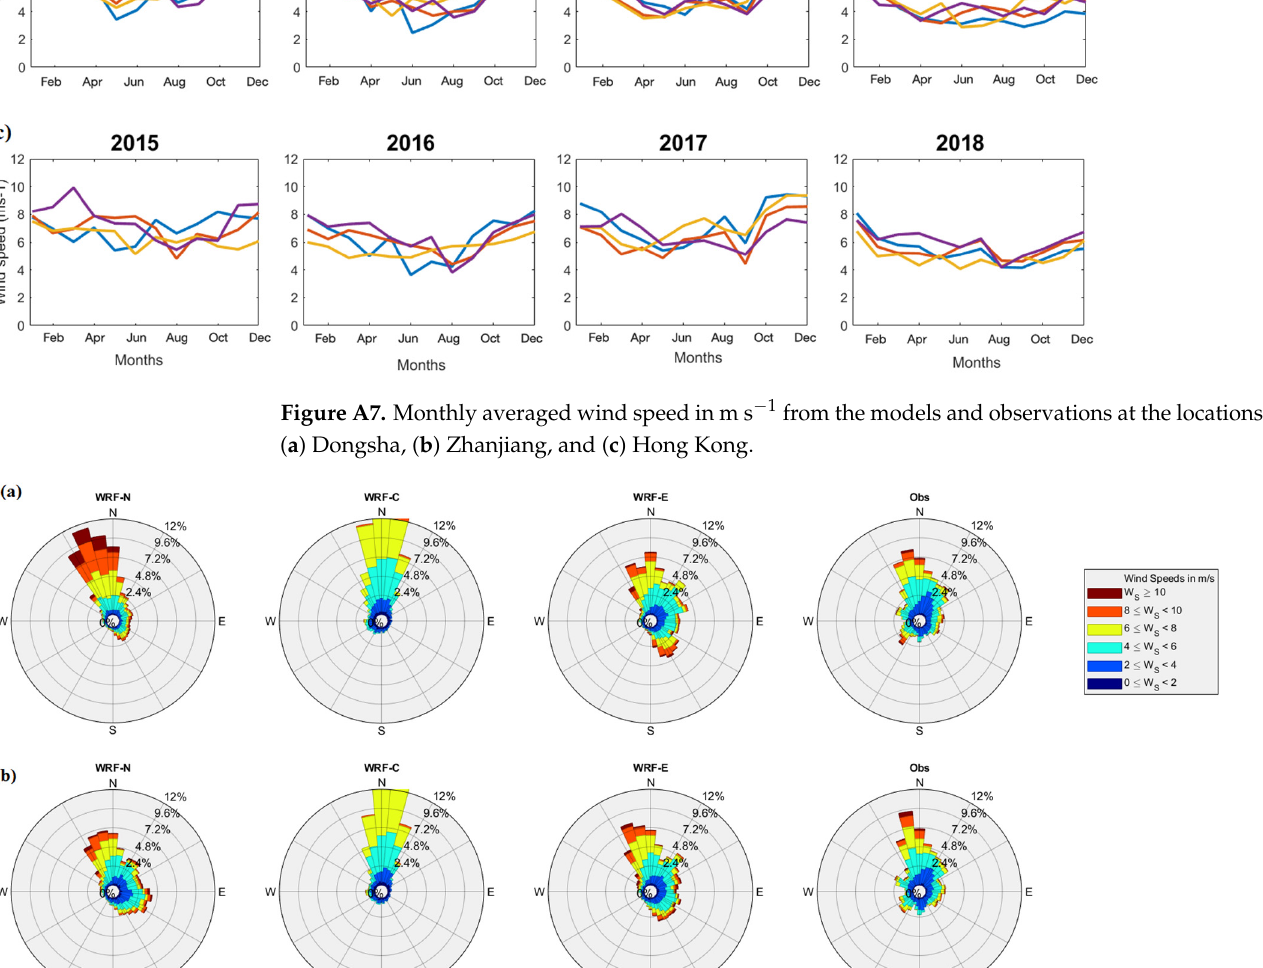
Figure A8. Wind rose diagram on an hourly timescale from the models and observations for the years ( a ) 2017 (top) and ( b ) 2018 (bottom) at Hong Kong.